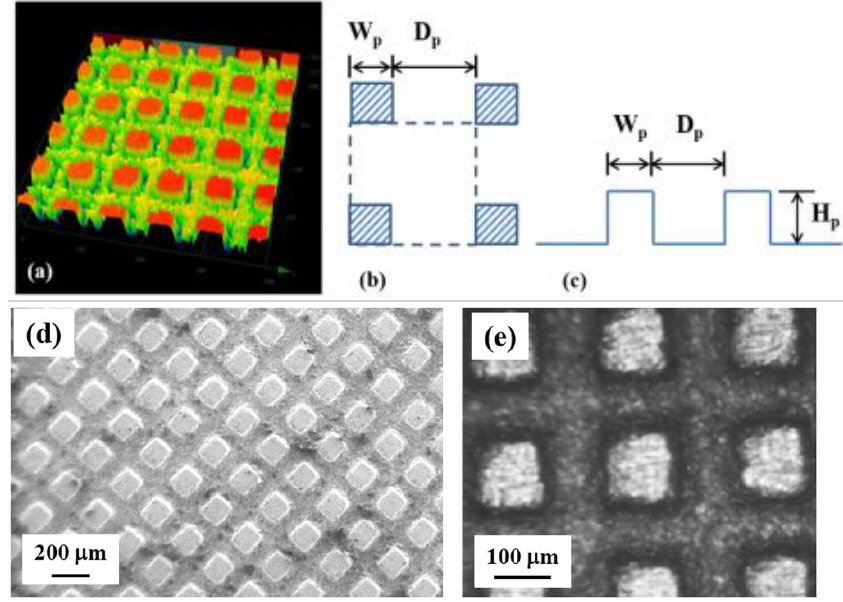
Figure 3. ( a ) Image of micropillar surface (MP) taken by a 3D optical profilometer. ( b ) Spatial distribution of micropillars on the flat surface (unit cell). ( c ) Geometrical parameters of MP: pillar width (W p ≈ 100 μ m), inter-pillar distance (D p ≈ 100 μ m) and pillar height (H p ≈ 80 μ m). ( d ) SEM image of MP taken after fabrication. ( e ) Optical microscope image of MP.